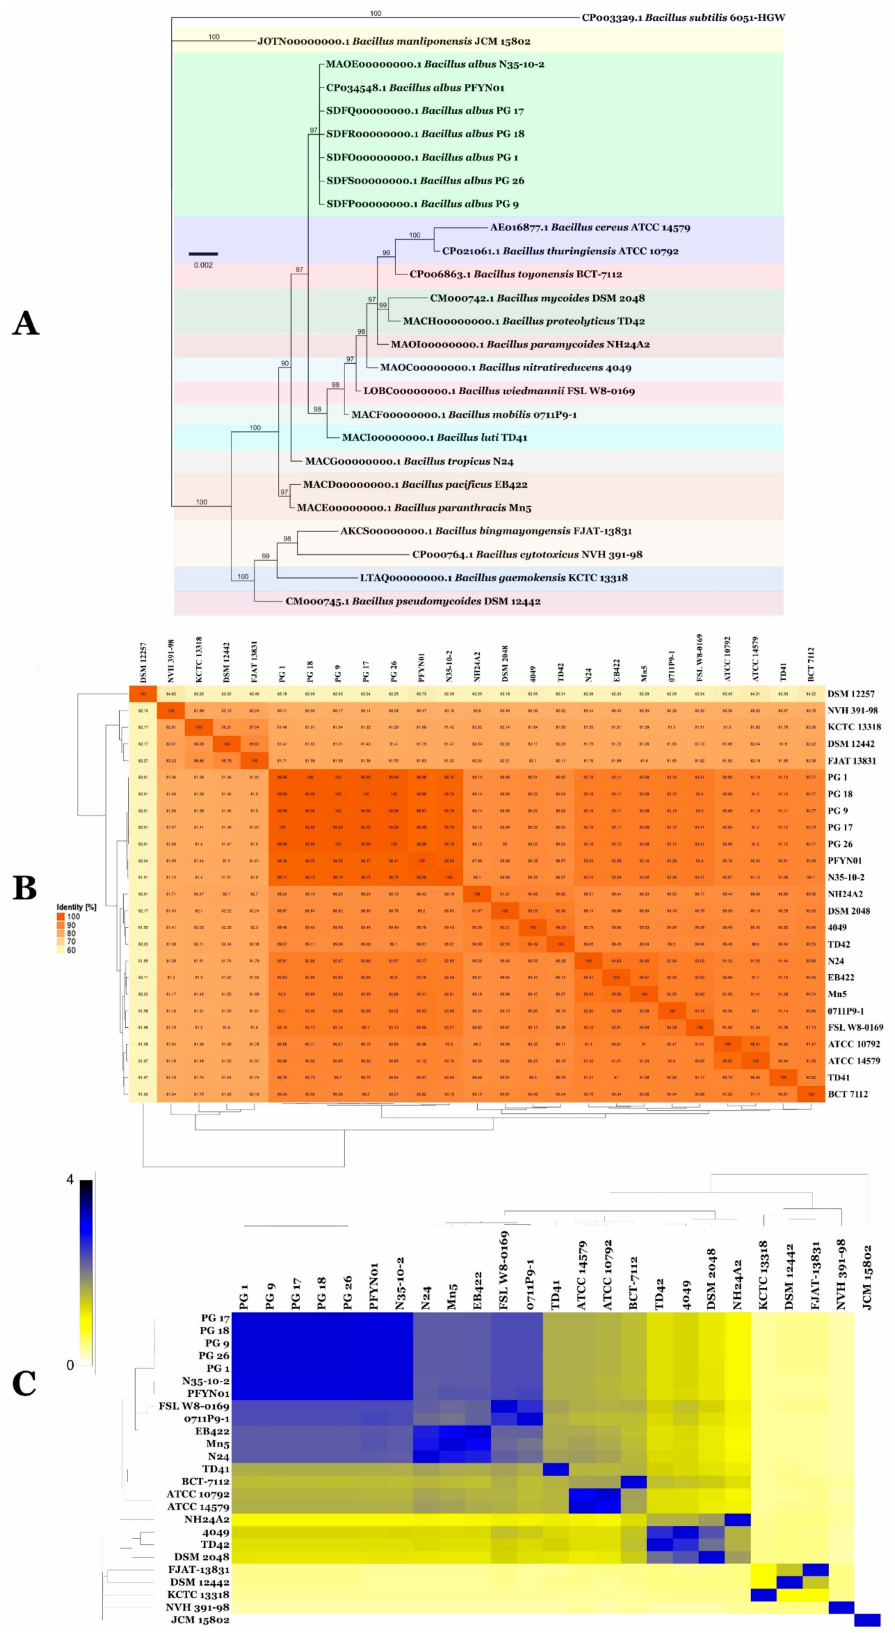
Figure 8. Bayesian inference phylogenomic tree of Bacillus albus and closest species ( A ). The tree was rooted with B. subtilis ATCC 6051-HGW. Bar, number of expected changes per site. ANI and GGDC values ( B , C ) between isolates generated using EzBiocloud and GGDC web